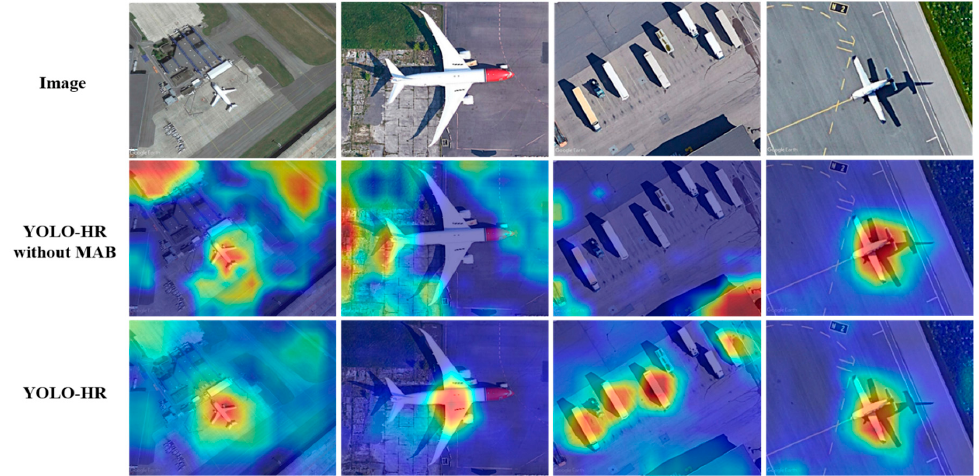
Figure 5. Heat map visualization of the partial detection results before and after adding the MAB module. Both are visualized with Grad-CAM [92].